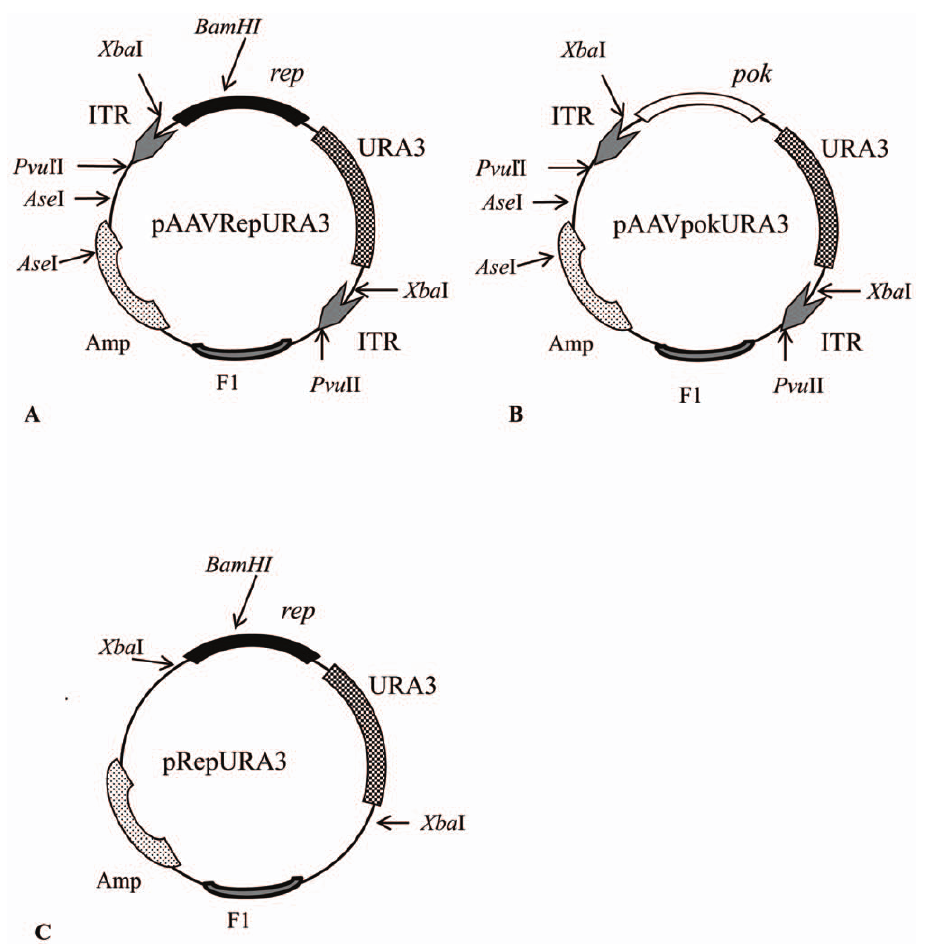
Figure 1. Schematic representation of plasmids. A) The vector pAAVRepURA contains wild type Rep gene and the yeast URA3 marker replacing the Cap gene flanked by the two ITRs. B) The vector pAAVpokURA contains a stuffer sequence, pok, instead of Rep gene. The ITRs are the only AAV sequence present in the vector. C) The vector pRepURA has the same sequences as pAAVRepURA without ITRs.